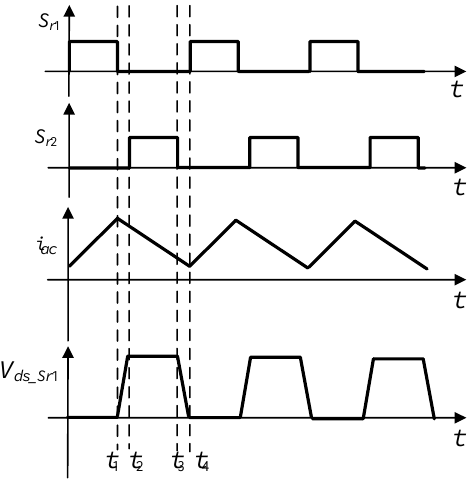
Figure 11. Typical waveforms of the high-frequency switching leg in TPCM.